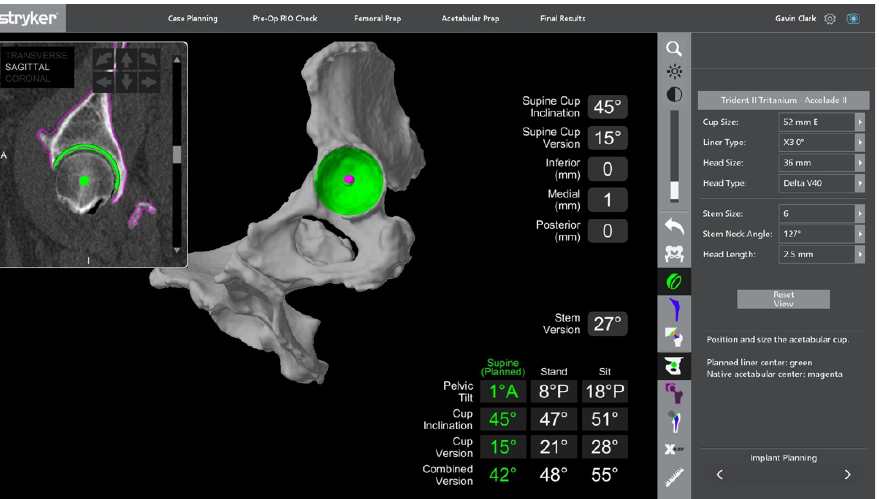
Figure 4. MAKO-assisted robotic THA planning cup placement. The green area is the planned bone to be removed when reaming, and the green dot indicates the planned cup centre.